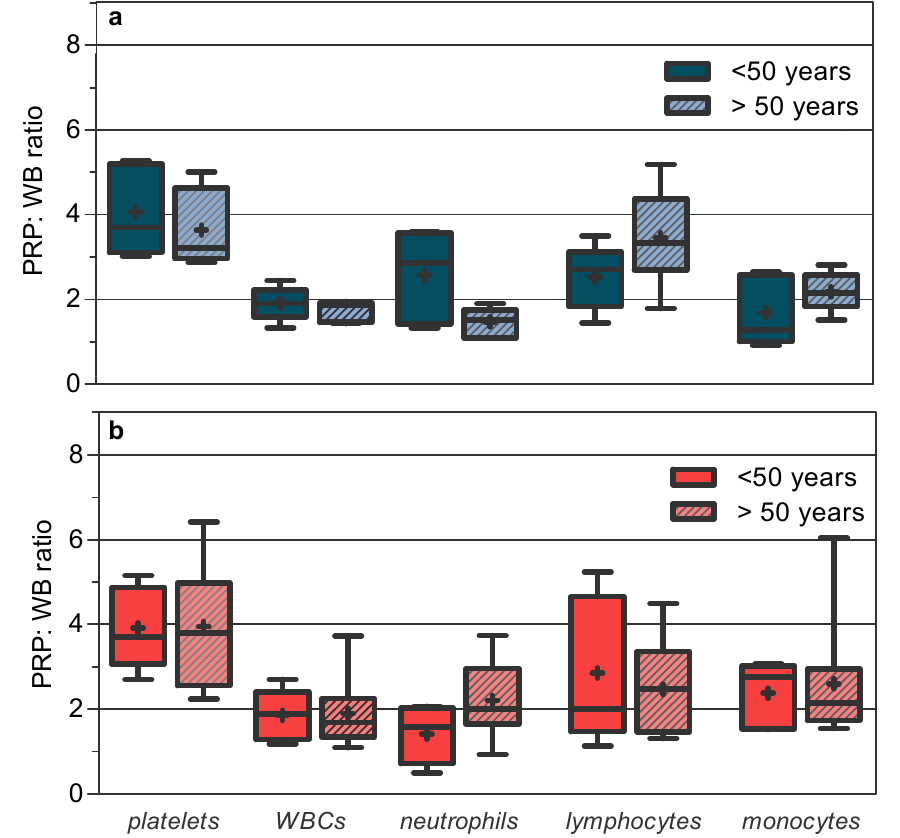
Figure 2. Increase in blood cell concentration factor (PRP/WB ratio) in age–sex groups using the Easy PRP kit: ( a ) men; ( b ) women.Box plot: median, line in the middle of the IQR box; mean, symbol +; whiskers, minimum to maximum. Mean (± SD) and median [IQR] for each blood cell: For the <50-year-old male group: platelets, 4.06 ± (1.07) and 3.70 [2.10]; WBCs, 1.91 (±0.40) and 1.90 [0.64]; neutrophils, 2.57 (±1.09) and 2.86 [2.16]; lymphocytes, 2.52 (±0.76) and 2.70 [1.29]; monocytes, 1.69 (±0.82) and 1.28 [1.57]. For the >50-year-old male group: platelets, 3.64 (±0.89) and 3.22 [1.66]; WBCs, 1.74 (±0.26) and 1.86 [0.45]; neutrophils, 1.47 (±0.34) and 1.51 [0.65]; lymphocytes, 3.45 (±1.15) and 3.32 [1.68]; monocytes, 2.18 (±0.46) and 2.15 [0.74]. For the female <50-year-old volunteers: platelets, 3.91 (±0.97) and 3.69 [1.82]; WBCs, 1.86 (±0.60) and 1.89 [1.12]; neutrophils, 1.41 (±0.68) and 1.57 [1.32]; lymphocytes, 2.85 (±1.72) and 2.00 [3.18]; monocytes 2.37 (±0.77) and 2.76 [1.49]. For the female >50-year-old volunteers: platelets, 3.95 (±1.39) and 3.79 [2.43]; WBCs, 1.90 (±0.80) and 1.69 [0.92]; neutrophils, 2.20 (±0.93) and 2.00 [1.32]; lymphocytes, 2.47 (±1.09) and 2.48 [1.89]; monocytes, 2.60 (±1.42) and 2.15 [1.2].